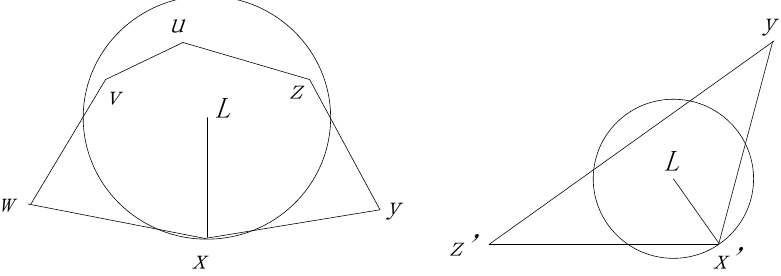
Figure 7. The destination locates out of the polygon and a simplified form.